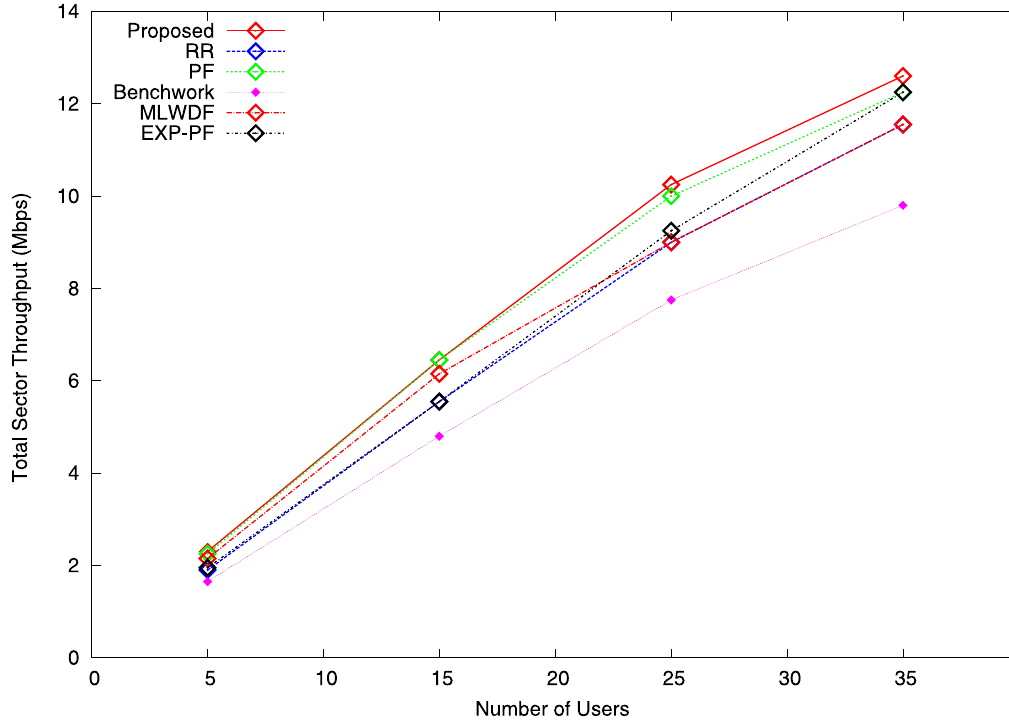
Fig 4. Total sector throughput VoIP traffic.